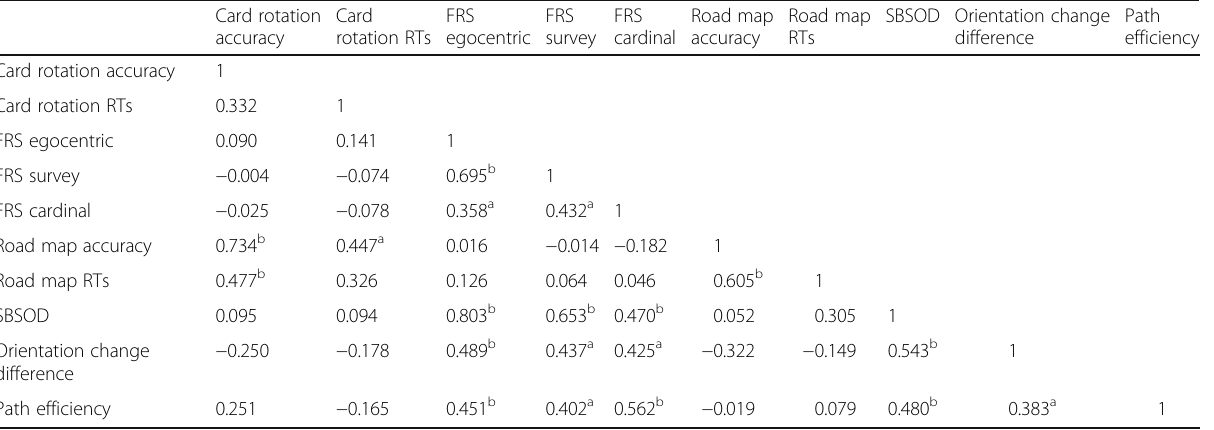
Table 2 details a correlation matrix relating individual differences to the heading change difference score and path efficiency. Higher spatial sense of direction and difference scores and path efficiency. In other words,